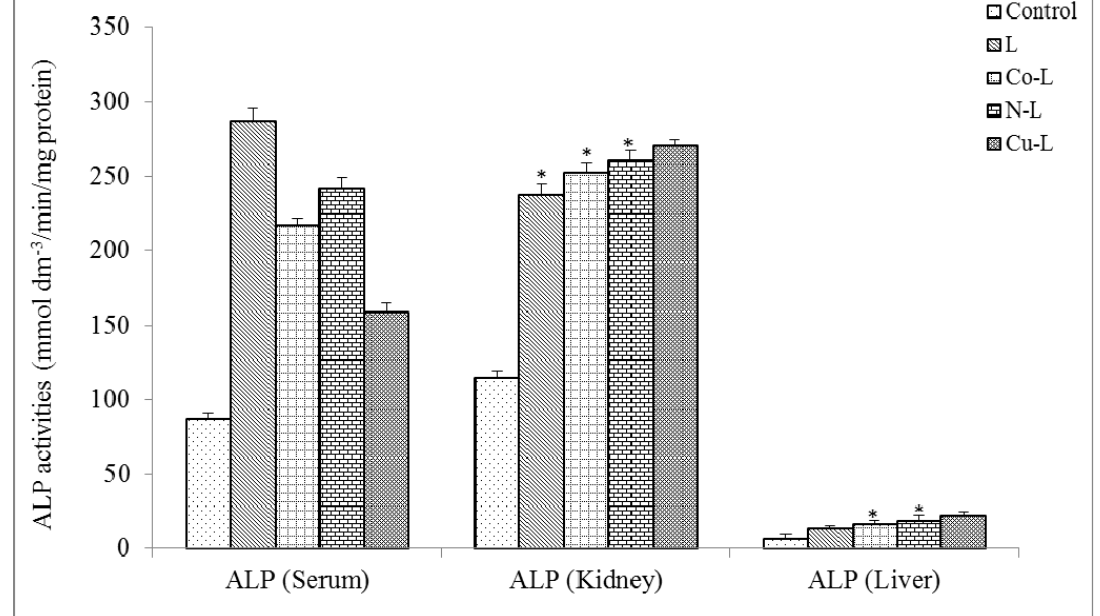
Figure 4. Effect of administration of ligand and the metal complex on the activities of alkaline phosphatase of rat serum, kidney and liver. * Significantly different from the control (p < 0.05).